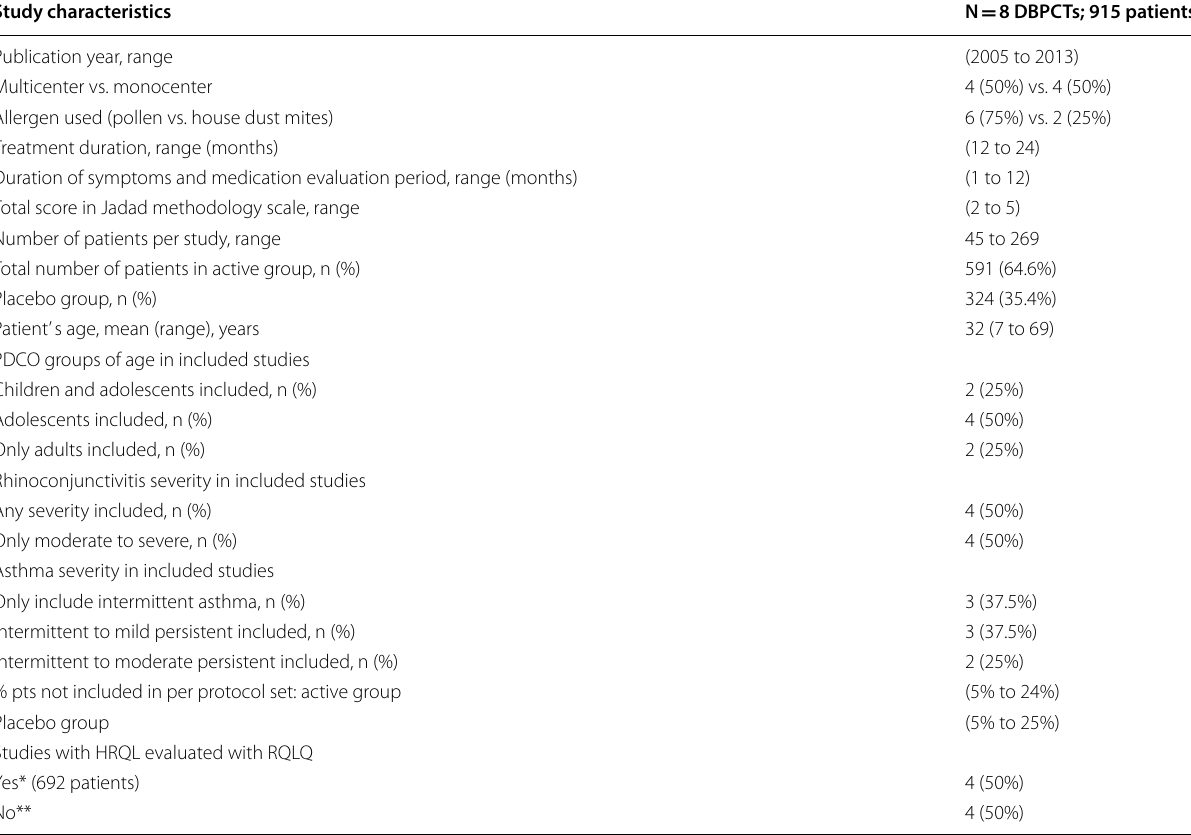
Table 1 Summary of articles and patient characteristics